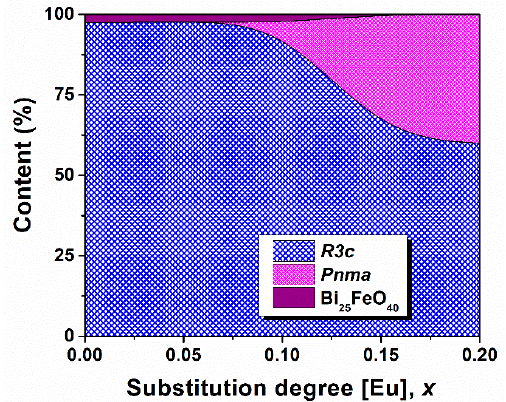
Figure 3. Phase composition evolution in Bi 1 − x Eu x FeO 3 calcined powders.